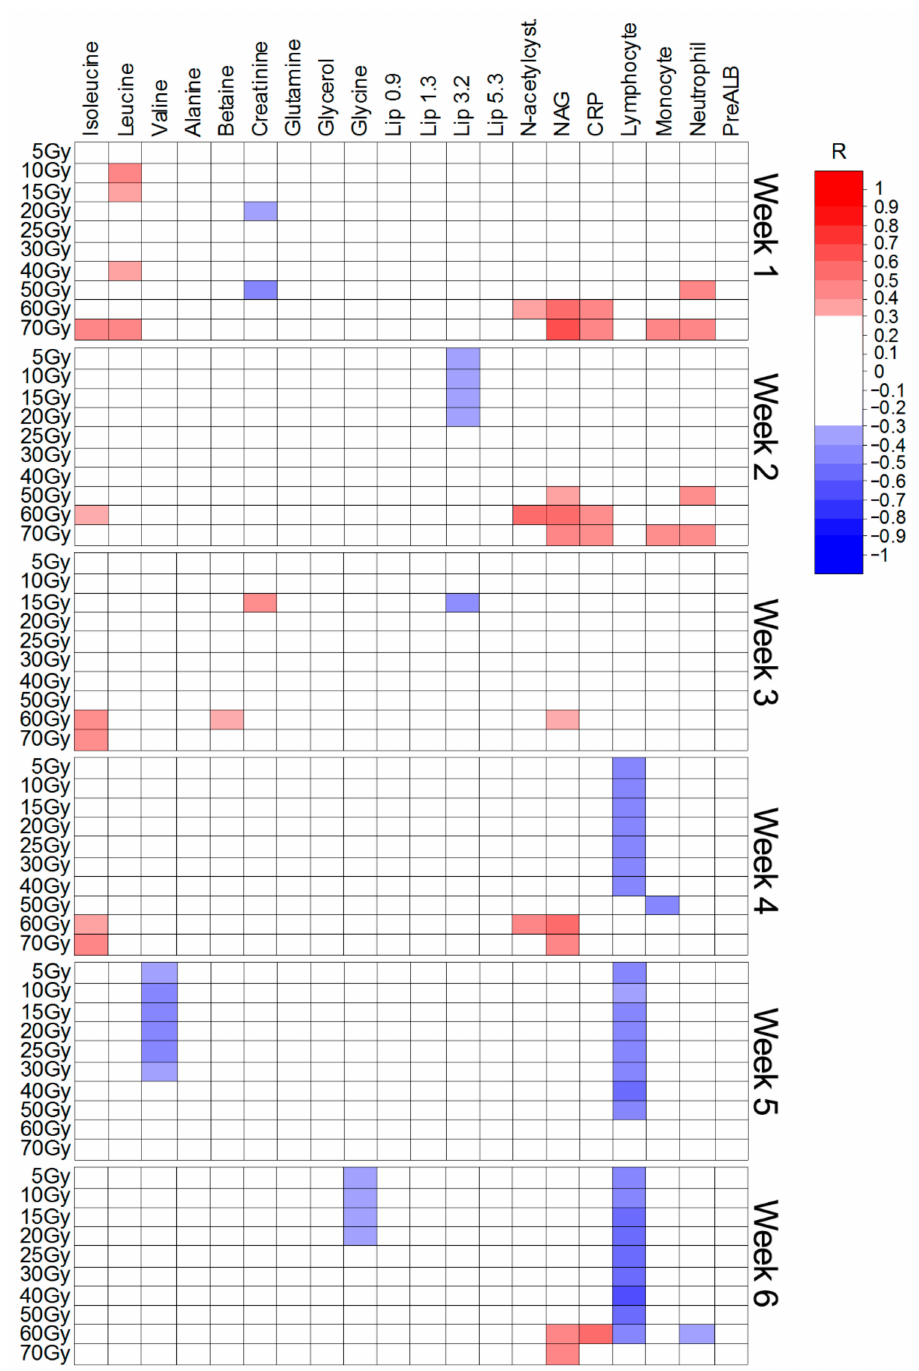
Figure 6. Heat map of the Spearman’s correlations between the blood serum metabolites and the irradiated volumes receiving a particular dose during CAIR/CONV/SIB fractionated